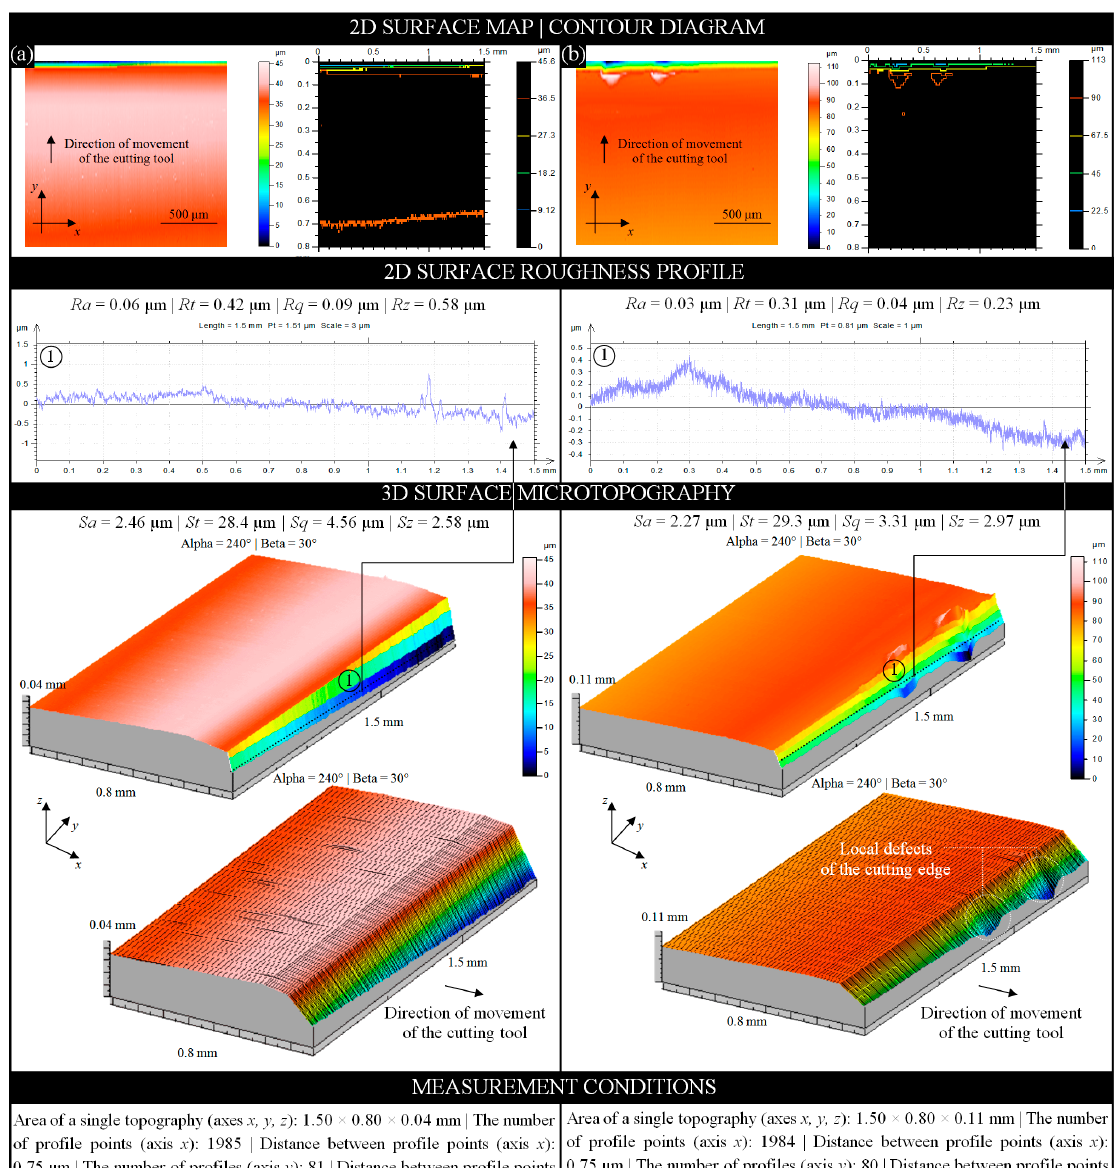
Figure 6. Collection of selected results of experimental studies obtained using multisensory optical profilometer Talysurf CLI2000 (Taylor-Hobson, Leicester, Great Britain) for a fragment of the cutting edge surface (1.5 × 0.8 mm) of planar cutting blade: ( a ) for sample B1-4; ( b ) for sample B1-5.